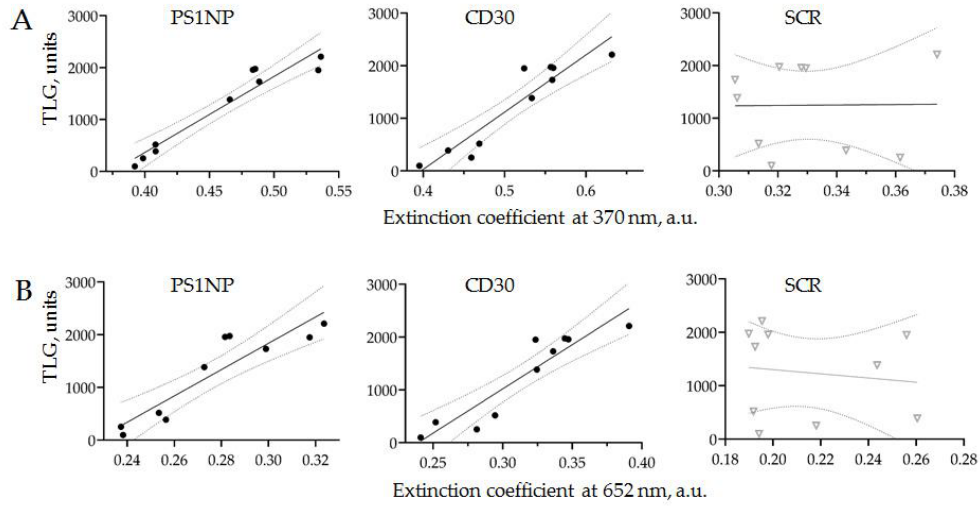
Figure 9. The correlation of the PET-CT results (TLG) and the assessment of HRS-cell-derived SEVs in the plasma of cHL patients using AuNP aptasensor. HRS-cell-derived SEVs were quantified using three types of aptamers: CD30, PS1NP and SCR as controls, and absorbance was measured at two wavelengths (370 and 652 nm).